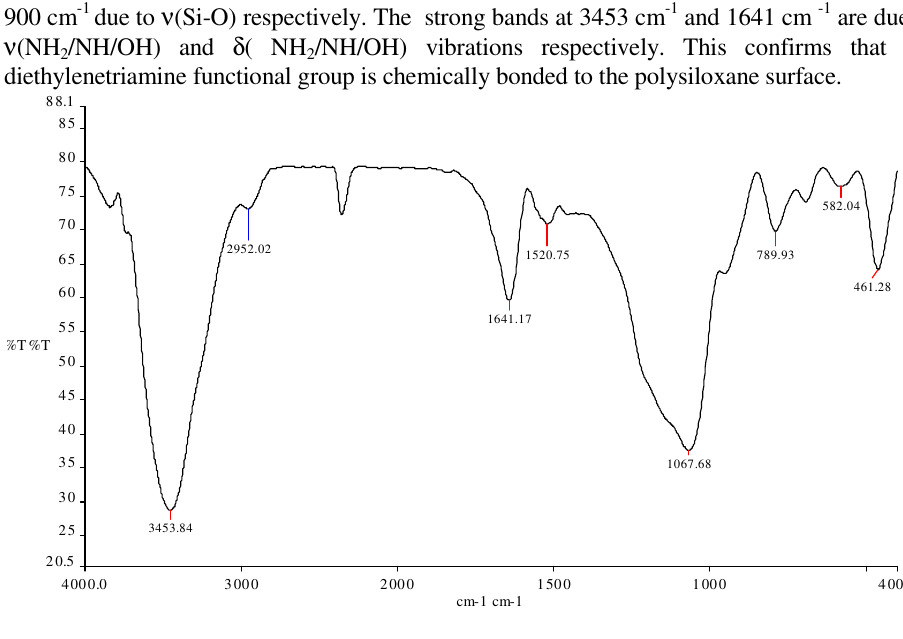
Figure 1 . FTIR spectrum of P-DTA